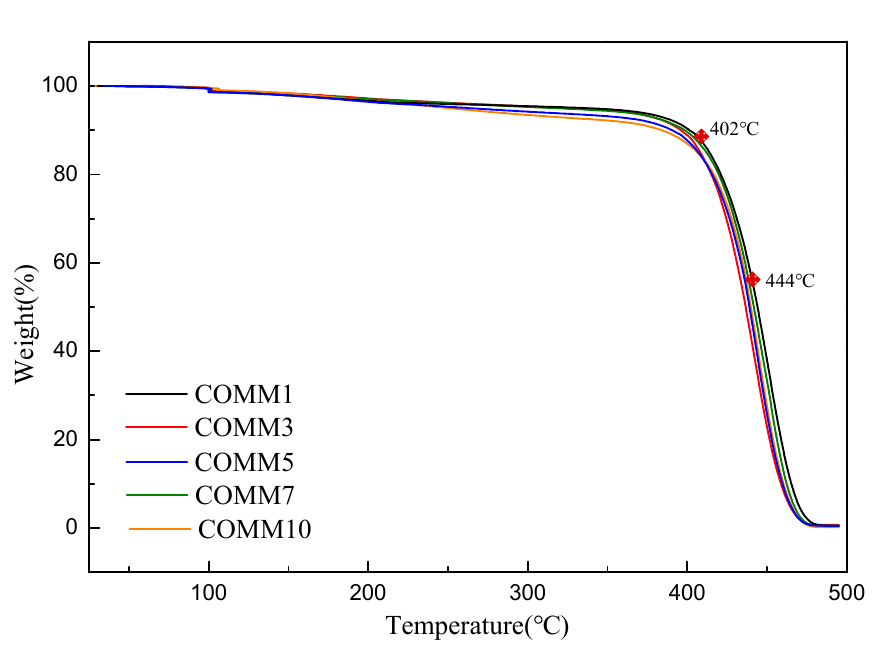
(cid:48) -Methylenebis(2-methylcyclohexylamine).